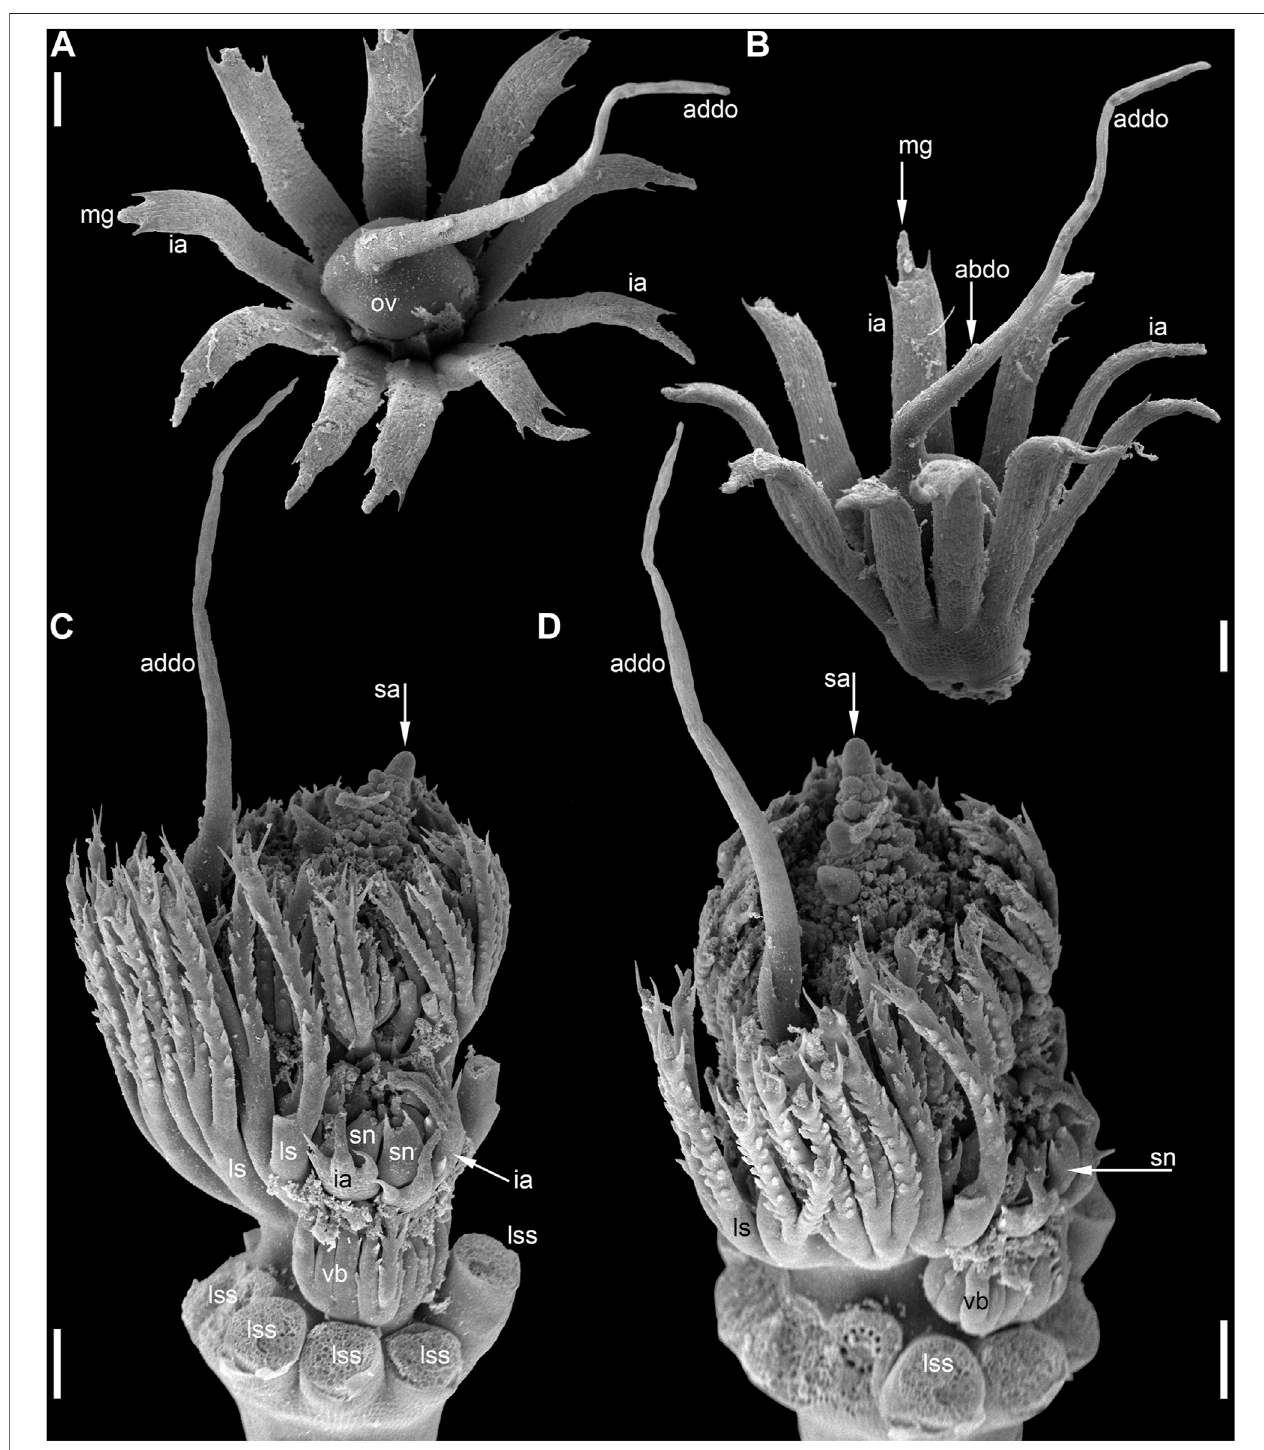
FIGURE 11 | Reproductive structures of Ceratophyllum submersum (SEM). (A,B) Two views of pistillate reproductive unit. (C,D) Two views of shoot apex with antheticpistillatereproductiveunitandpre-antheticstaminatereproductiveunitlocatedanodebelow.Thereisalsoavegetativebranchlocatedrightbelowthestaminate reproductive unit in yet another node. The staminate reproductive unit has numerous stamens and a peripheral whorl of involucral appendages. Scale bars = 300 μ m in (A – D) .